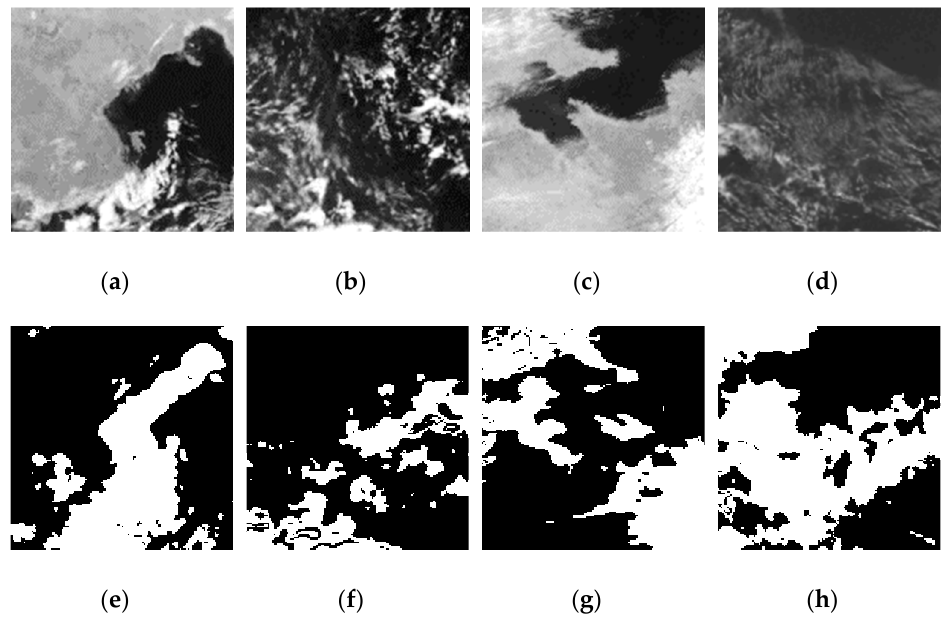
Figure 3. NSMC error detection cloud examples. ( a – d ) are original images, ( e – h ) are the corresponding cloud detection results of ( a – d ).